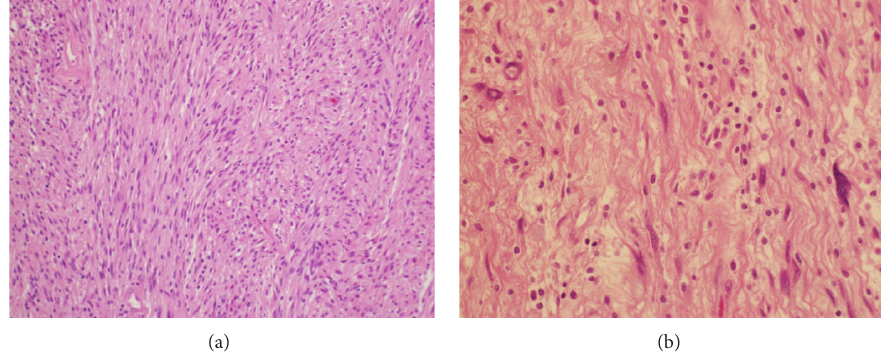
Figure 2: Microscopic examination of the pancreatic tail tumor. (a) Tumor was composed of monomorphic spindle-shaped Schwann cells with poorly defined eosinophilic cytoplasm and pointed basophilic nuclei set in a collagenous stroma. Focal nuclear palisading is noted (H&E stain, magnification power: 10x). (b) Areas characteristic for Antoni B composed of Schwann cells with inconspicuous cytoplasm and nuclei suspended in myxoid matrix are identified. Scattered degenerated nuclei in a hyalinized stroma suggestive of ancient schwannoma were present. No mitosis or necrosis was noted (H&E stain, magnification power: